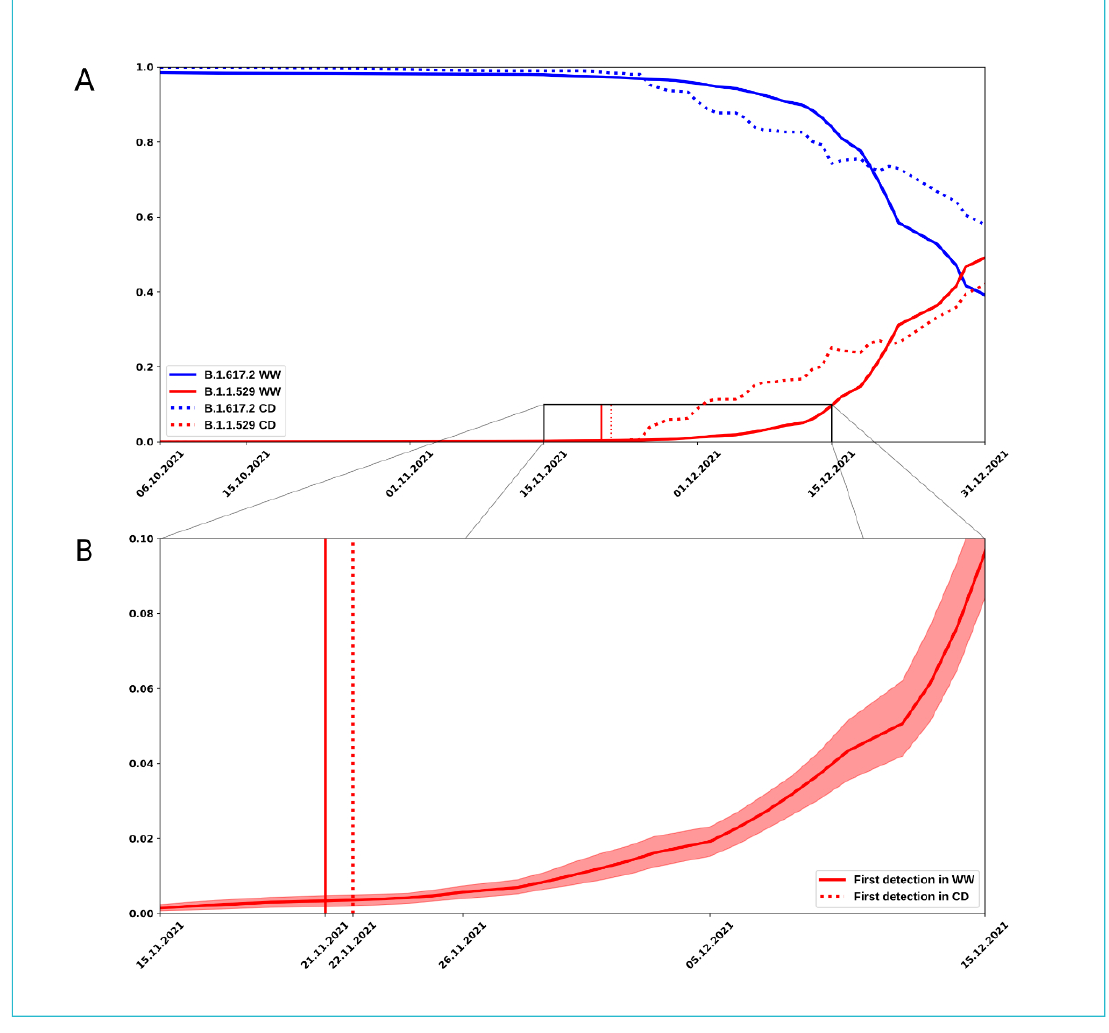
Figure 2: Prevalence of B.1.617.2 (Delta) and B.1.1.529 (Omicron) variants of SARS-CoV-2 in wastewater samples and confirmed cases A) Estimated prevalence of B.1.617.2 (Delta; blue) and B.1.1.529 (Omicron; red) variants of SARS-CoV-2 in wastewater in the city of Basel (ridge regression and LOESS smoothing; solid lines; WW wastewater) and among confirmed cases (from clinical swab test; rolling average of 20 days; dashed lines; CD case data) are shown. These curves were generated using data from samples spanning from July 1, 2021, until Janu- ary 13, 2022. The boxed region is depicted in more detail in panel B. B) Zoomed-in prevalence focusing on the period November 15 to De- cember 15, 2021, and fraction range [0;0.1] of initial increase of B.1.1.529 (Omicron) after the first detection in wastewater on November 21, 2021, and confirmed cases on November 22, 2021, with confidence bands. Curves were estimated by performing ridge regression followed by LOWESS smoothing on the individual SNVs over the considered period. Mutation proportions were deconvolved into variant proportions by ridge regression and temporally smoothed using